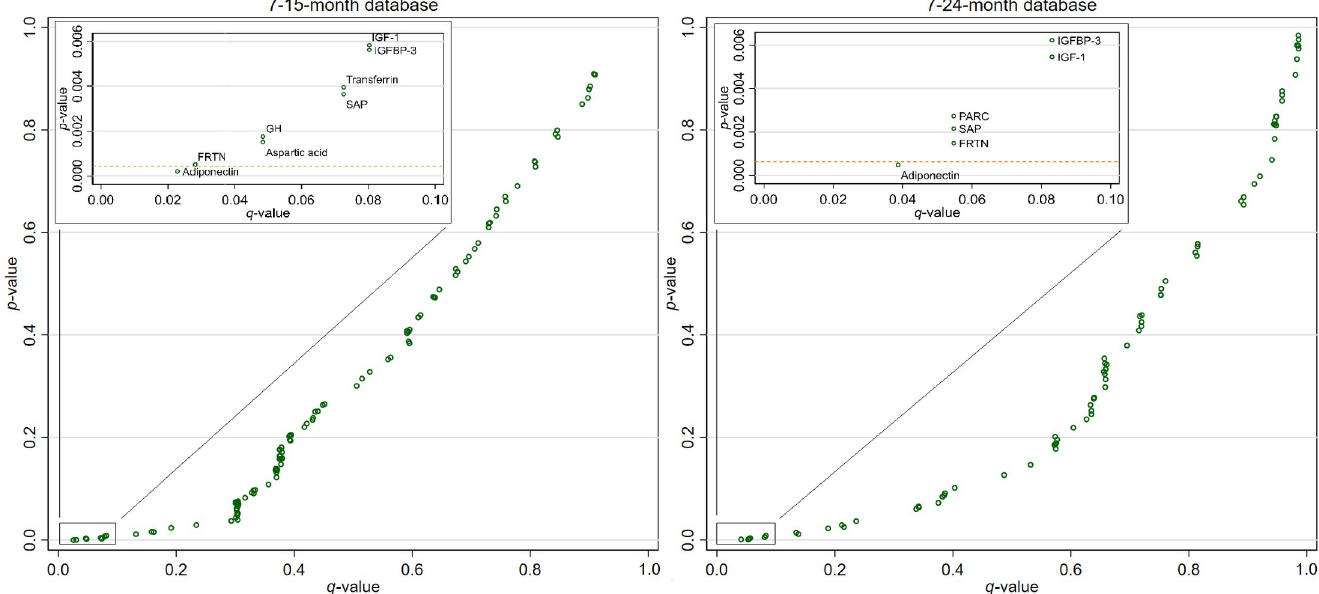
Fig 2. Scatterplot comparing the p -values from the separately modeled biomarkers to their corresponding q -values calculated using the method proposed by Simes’ method [33] and to the Bonferroni corrected α values (represented by the dashed lines). Biomarkers for which q < 0.1 are labeled.